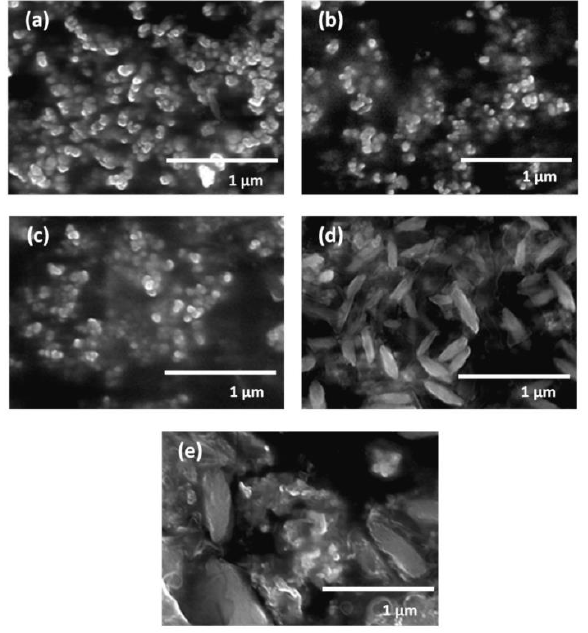
Figure 32. FE-SEM of graphite nanoparticles at laser frequency of ( a ) 1 Hz, ( b ) 10 Hz, ( c ) 20 Hz, ( d ) 50 Hz, and ( e ) 100 Hz. [81]